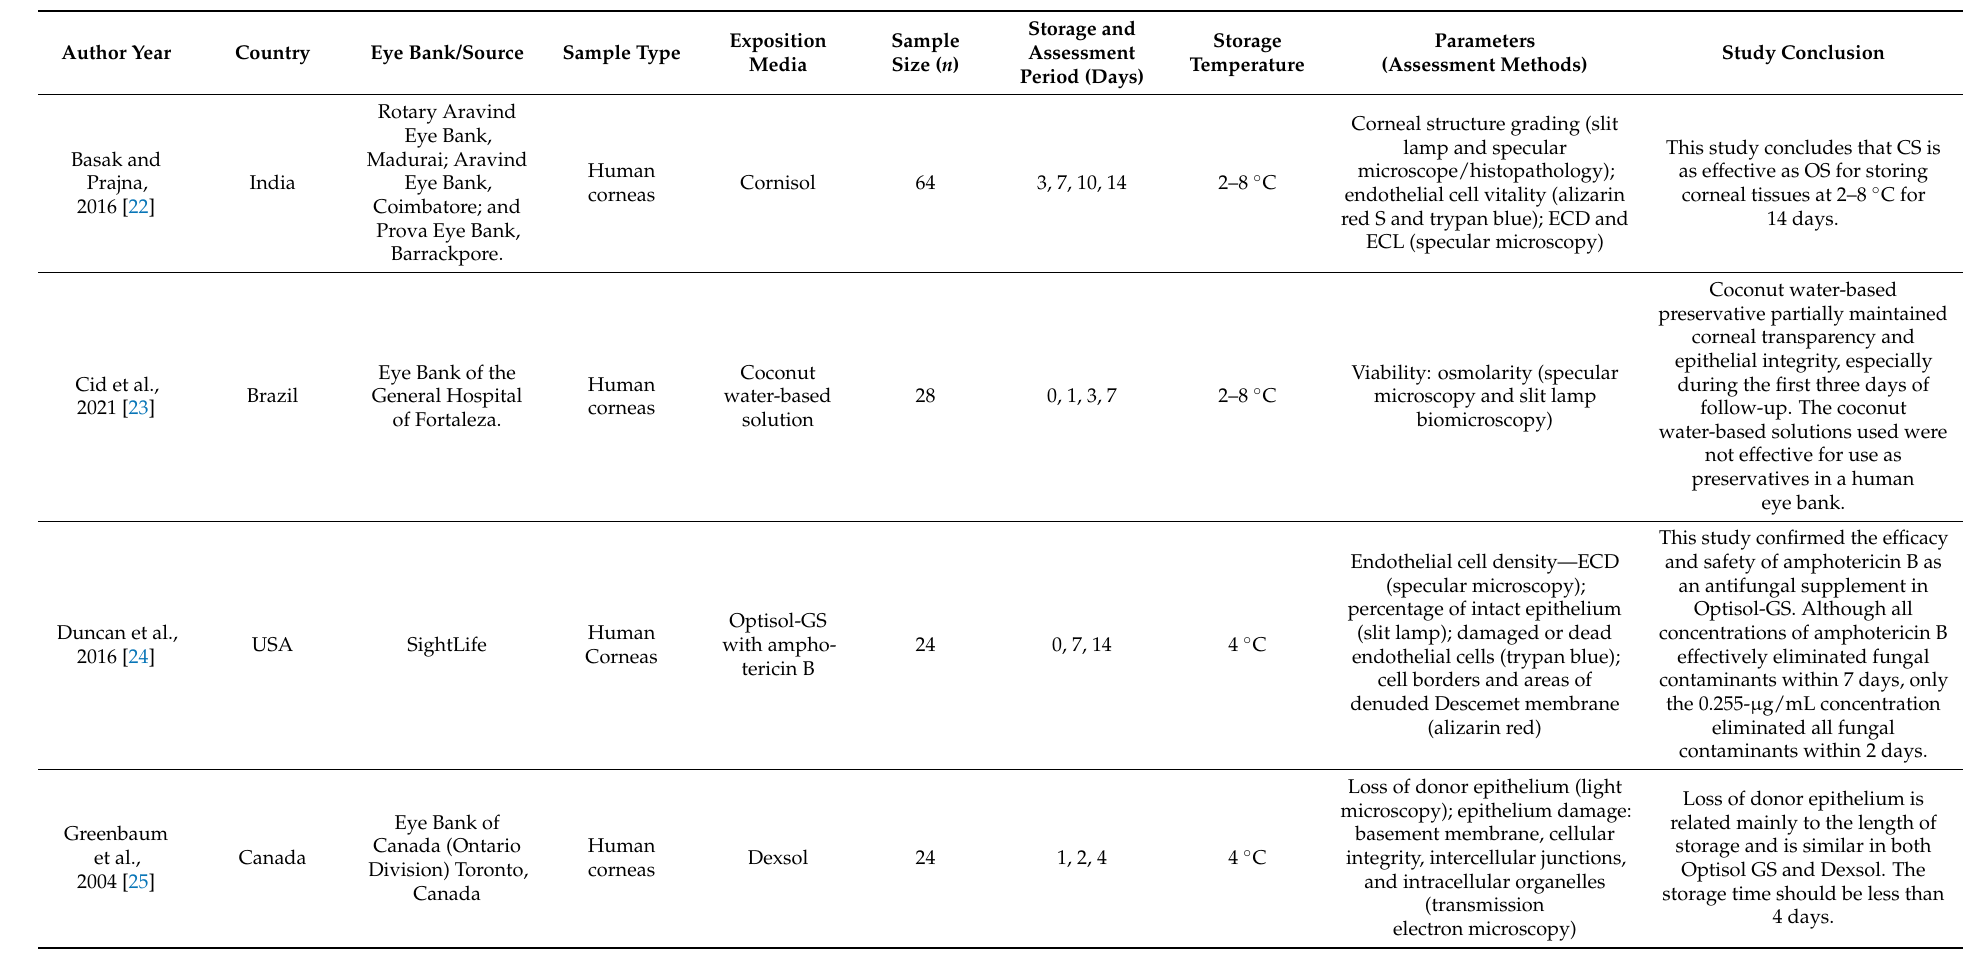
Table 4. Main characteristics of the selected